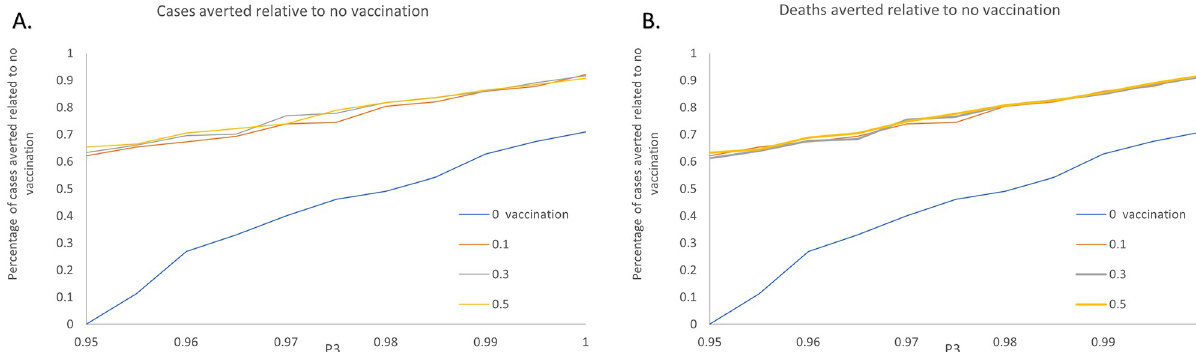
Fig 11. Impact of combined interventions on aversion rate compared with no vaccination scenario. A: Cases aversion rate. E-H: Deaths aversion rate.